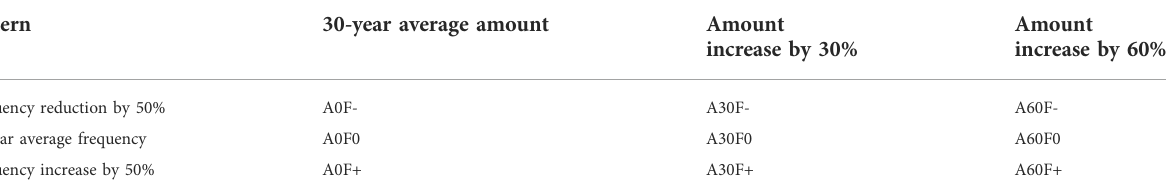
TABLE 1 Factors of the experimental